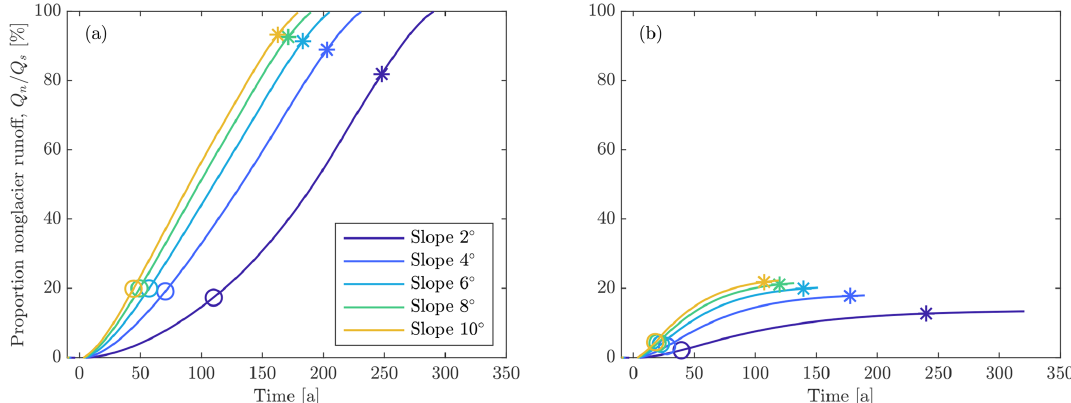
Figure 7. Percent contribution of nonglacier runoff to basin runoff without vegetation for a maritime climate during (a) RCP8.5 and (b) RCP2.6 climate change scenarios. Circles and asterisks indicate the time to peak basin runoff and to return to preretreat levels of basin runoff,